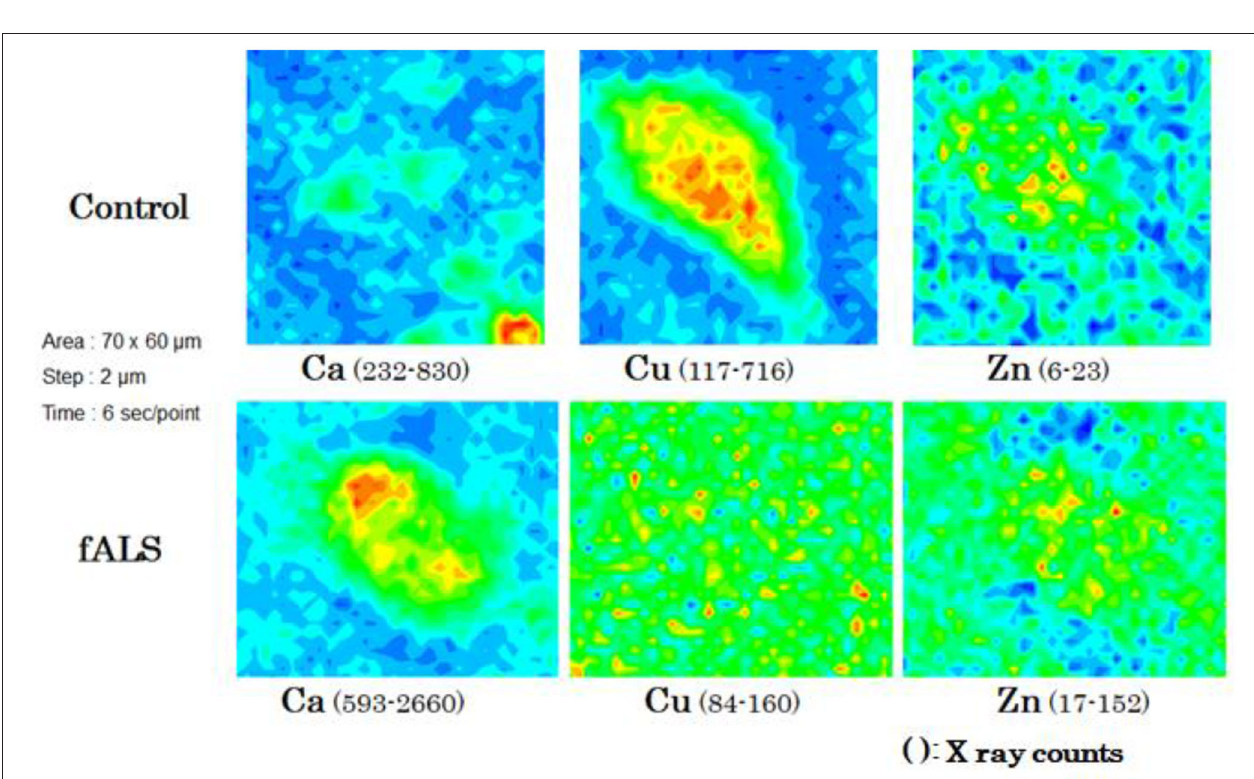
FIGURE 3 | Chemical mappings of Ca, Cu, and Zn of a single motor neuron obtained from fALS and control cases.